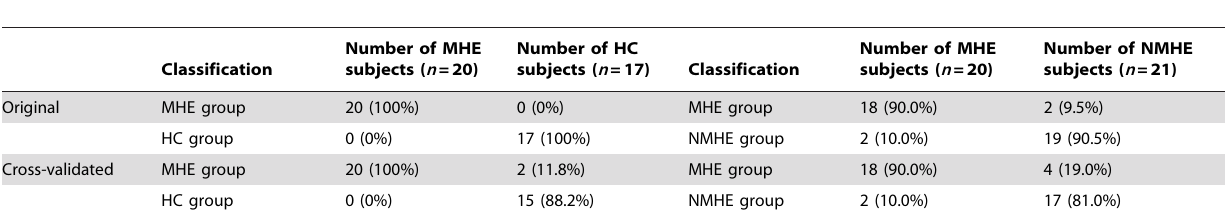
Table 5. Results of linear discriminant analysis between MHE patients and NMHE patients or between MHE patients and HC, with the functional connectivity strength of ROIs from three attention-related networks as